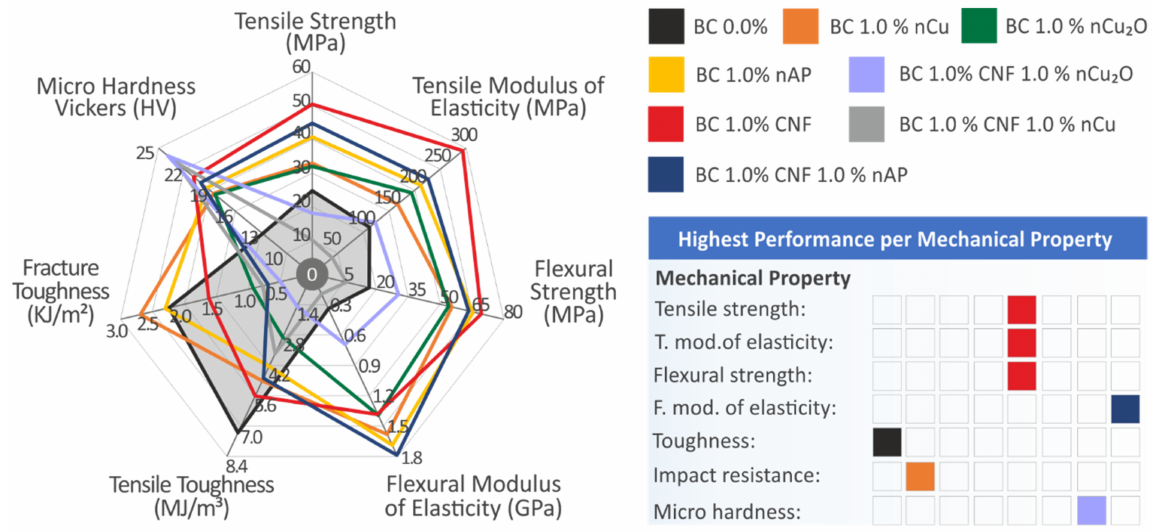
Figure 15. A summary of the mechanical performance results for all tested materials ( left ) and a table for the materials with the highest measured/calculated values ( right ) are shown. The shaded region on the spider graph represents the pure resin’s measured mechanical